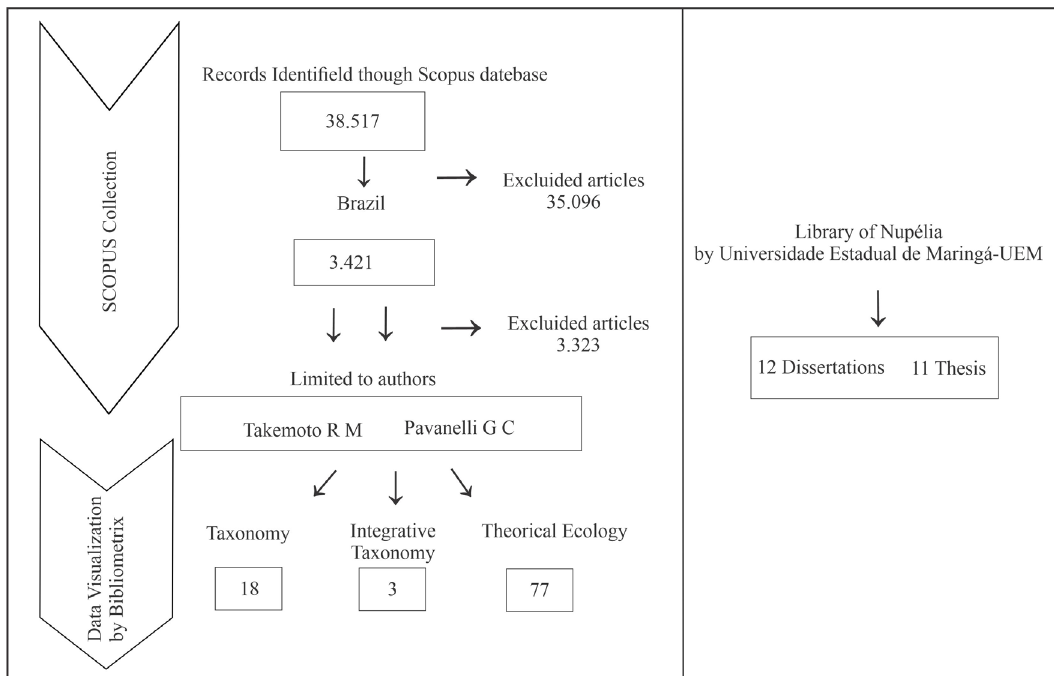
Figure 2. Summary flowchart of the SCOPUS data extraction and the quantification of work done in the 37 years of studies in the upper Paraná River